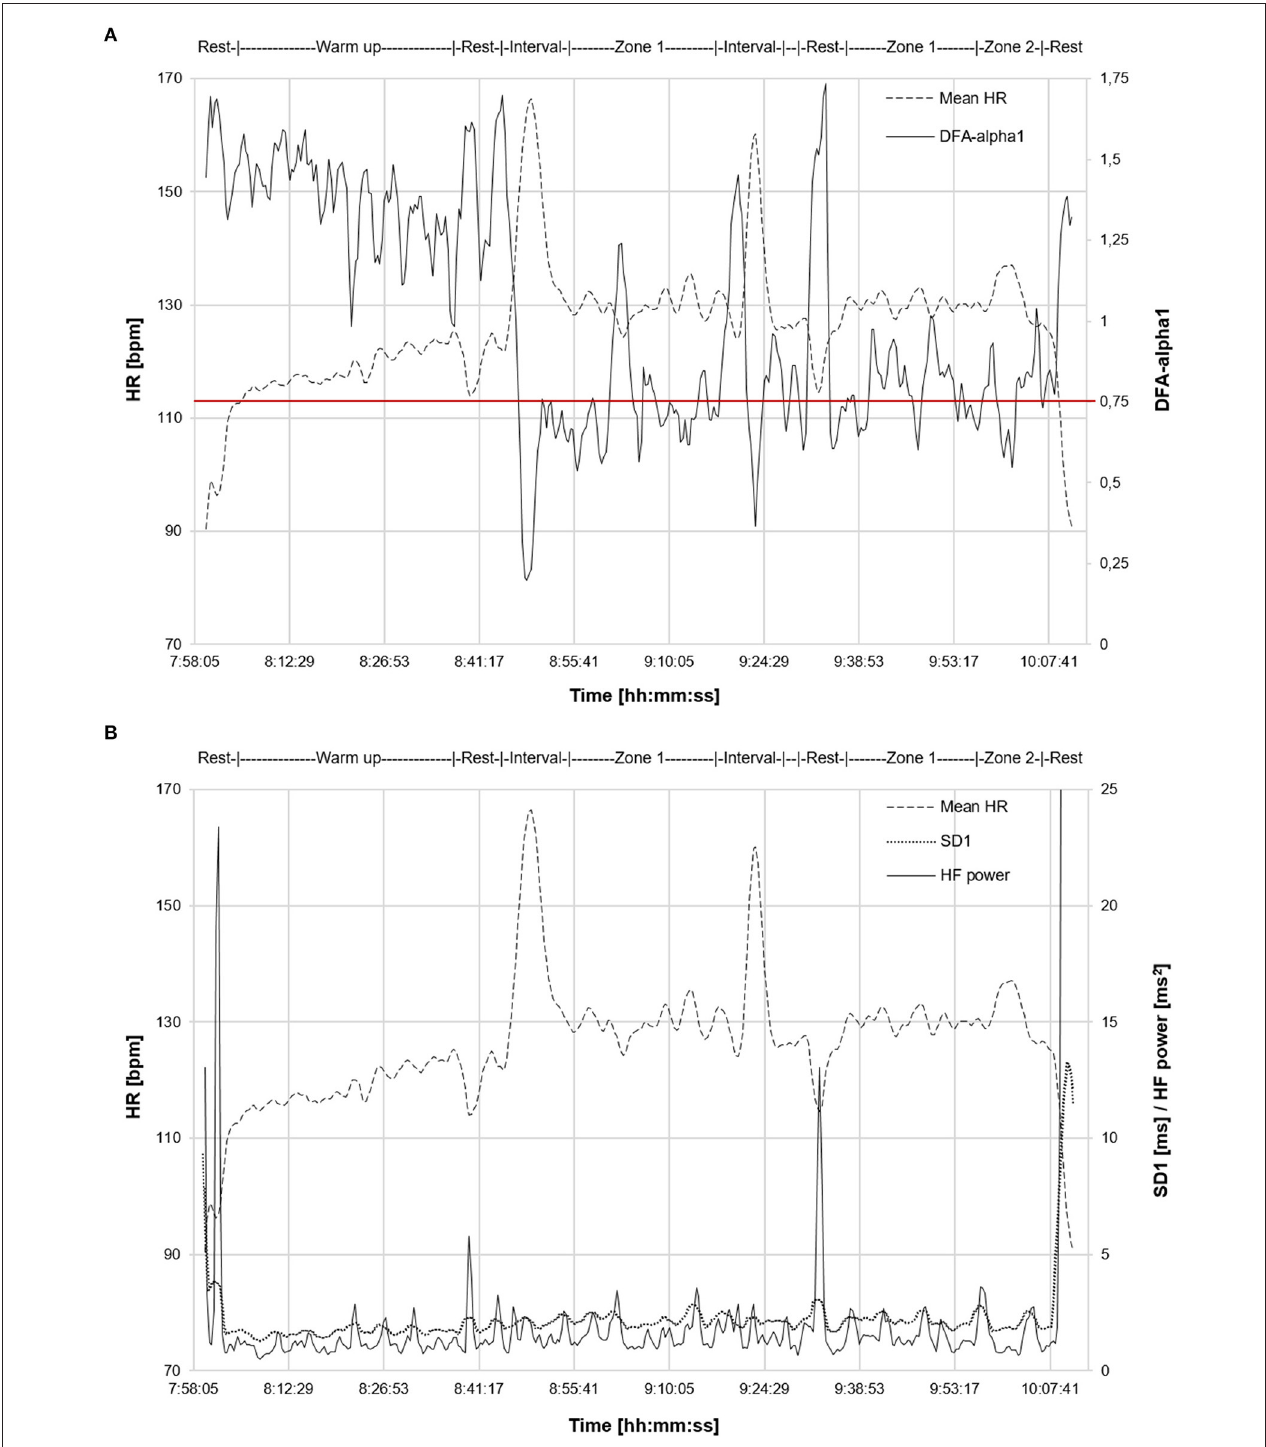
FIGURE 3 | Time-varying analysis (window width: 120s, grid interval: 20s) of a 2h exercise session from a master cyclist with a previously measured VT1 at HR 130 bpm by gas exchange. Data recorded with a commercial chest belt monitor (Suunto Movesense, Vantaa, Finland) and processed in Kubios HRV Software (Version 3.4.1) using automatic correction method (artifact percentage below 0.5%). (A) Mean HR and DFA-alpha1 are plotted over time. (B) Mean HR, SD1 and HF power are plotted over time. Intensity range of exercise (warm up, brief rest, zone 1, zone 2 and high intensity intervals) indicated on graph. DFA-alpha1: short-term scaling exponent alpha1 of detrended fluctuation analysis, VT1: first ventilatory threshold, SD1: standard deviation 1 from Poincaré plot HRV analysis (short-term index), HF power: high frequency power of frequency-domain HRV analysis.